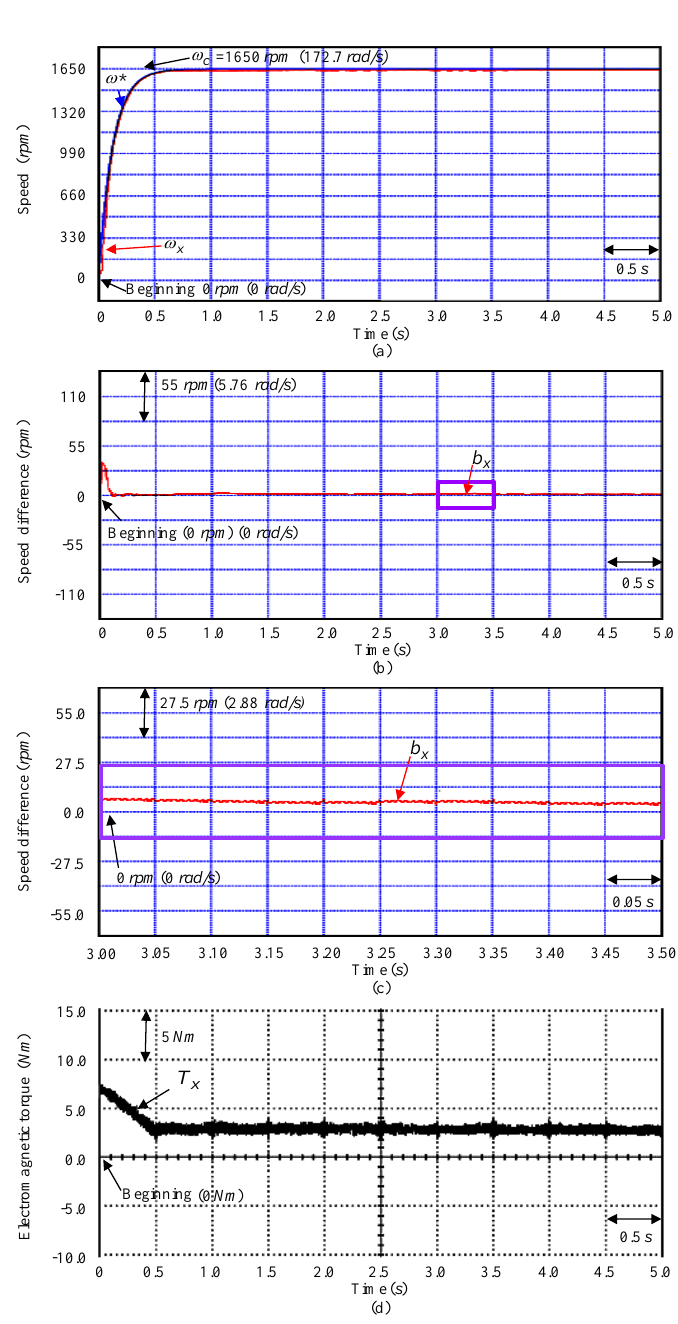
Figure 8. Tested instances with experimental results obtained by using the controller CD2 for the SSCCRIM impelled continuously variable transmission assembled system at the examination Y1 instance: ( a ) speed response, ( b ) speed difference response, ( c ) enlargement of speed difference response, ( d ) electromagnetic torque response .